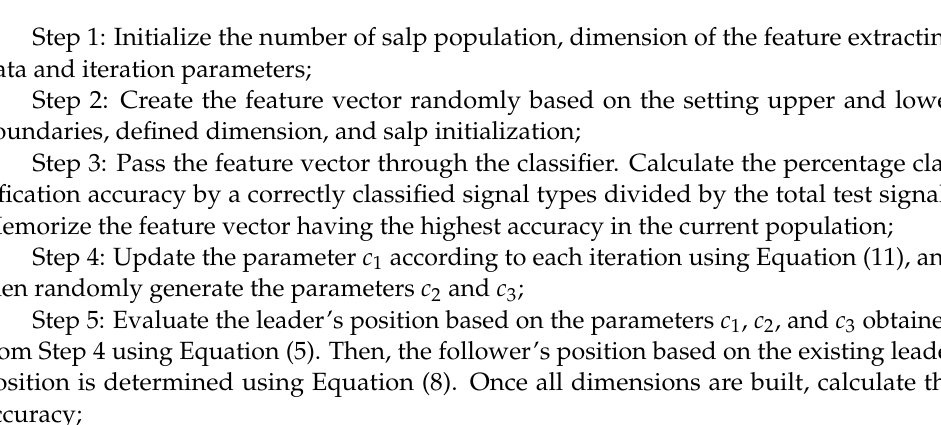
Figure 3. Pseudocode of the proposed adaptive